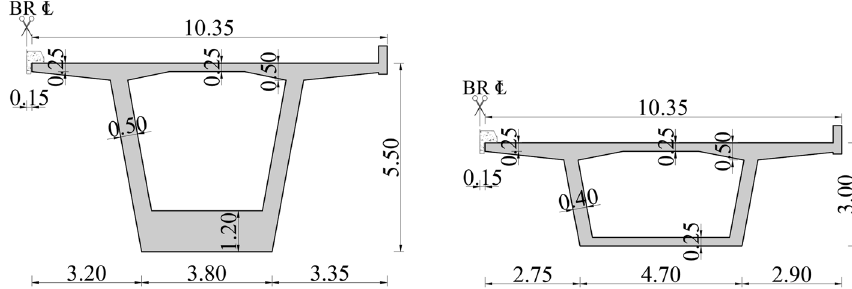
Fig. 18 Typical cross-sections of Talkha Bridge at inner piers and at mid navigation